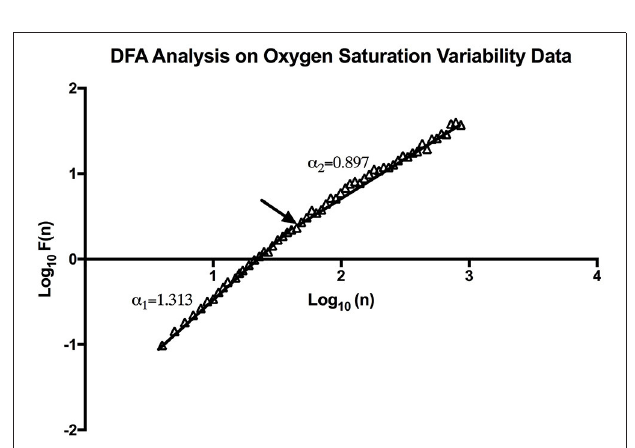
FIGURE 5 | Graph showing the linear relationship that exists between sample entropy and the mean SpO 2 level. The points are representative of the participants in the study, and “r” is the calculated Pearson correlation